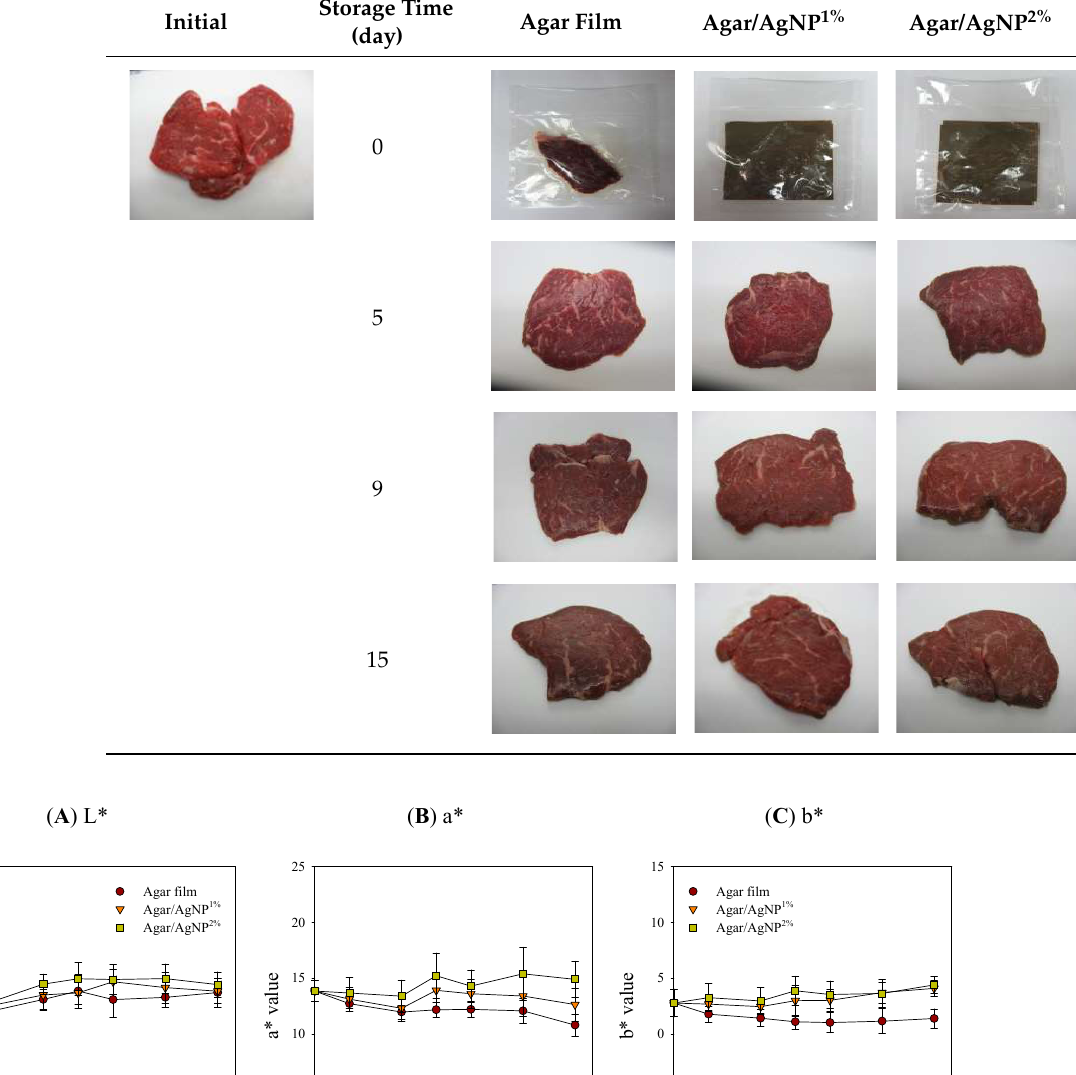
Table 1. The appearance of beef samples packaged with agar/AgNP composite films.